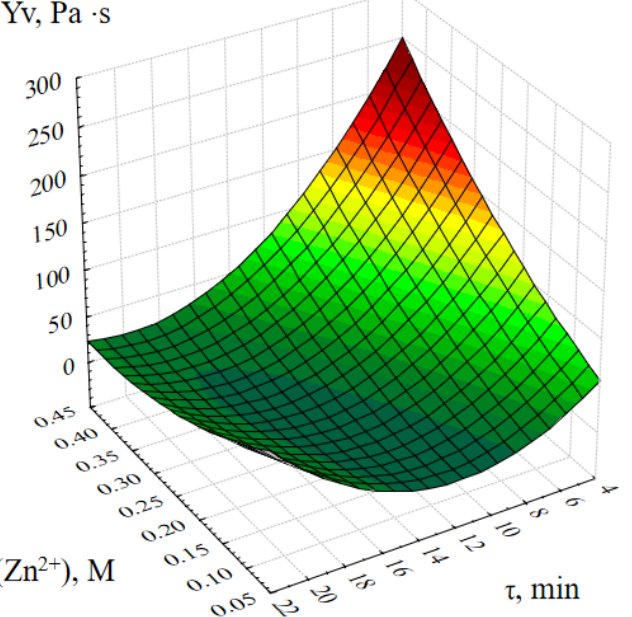
Figure 3. Response surface of the Y v output parameter depending on the concentration of zinc acetate and the duration of synthesis.